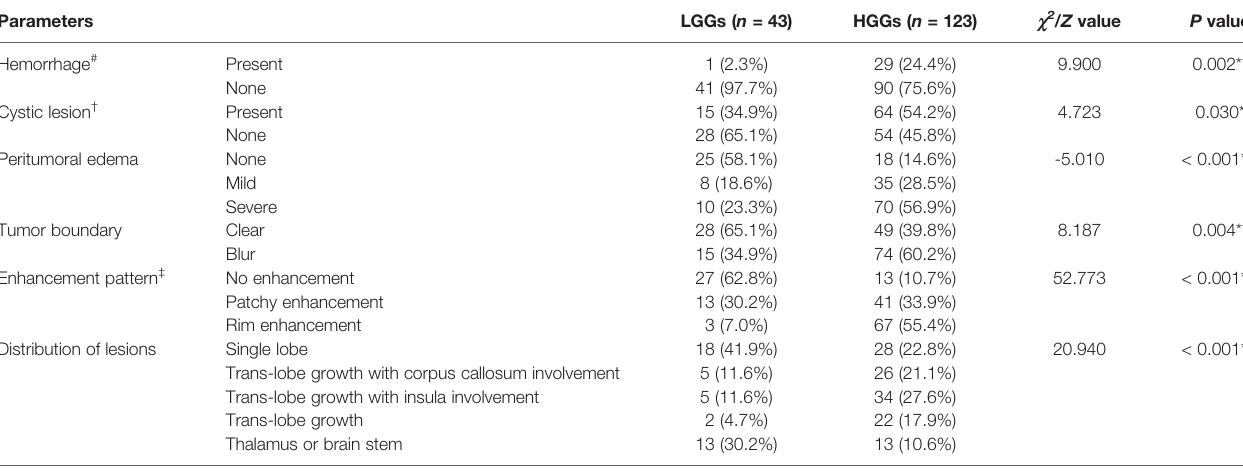
TABLE 2 | Comparison of MRI morphological characteristics of LGGs and HGGs. Parameters LGGs ( n = 43) Hemorrhage #